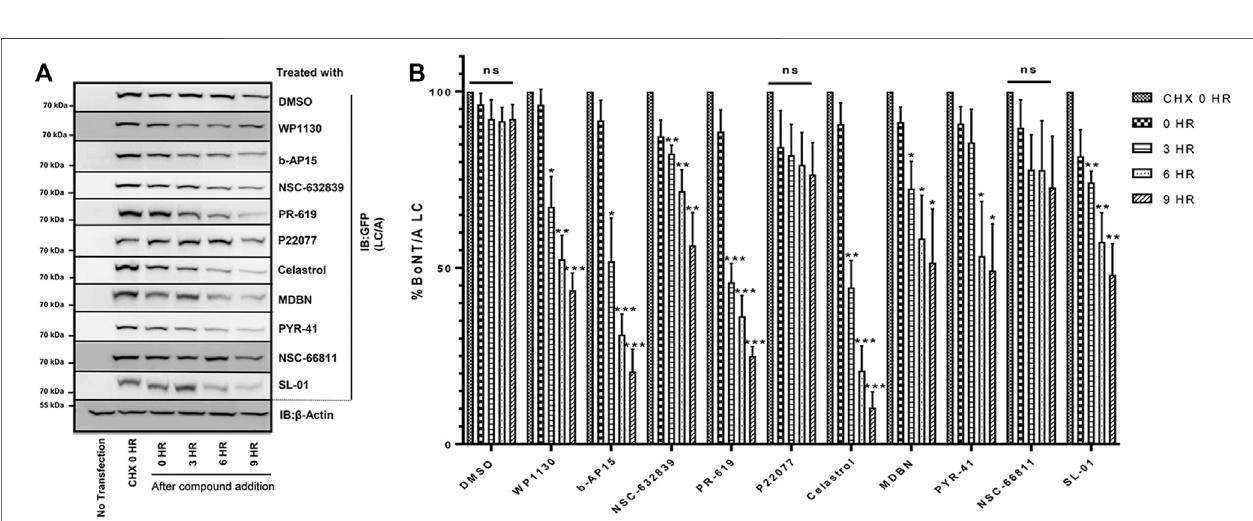
FIGURE5| Selected Compounds Enhancethe Degradation ofBoNT/A LC inCells (A) Representativewesternblot images demonstratingYFP-LCA protein levels attheindicatedtimepoints.HEK293cellsweretransfectedwithYFP-LCAandafter24 hincubatedwithCHX.After2 hofincubationwithCHX,mediawasremoved,and selectedcompounds(20 µM)wereaddedtothecellsandincubatedfortheindicatedtimepoints. “ CHX0 h ” indicatesthetimepointwhenCHXwasadded. “ Compound treatment 0 h ” indicates the time point when compound treatment was conducted. YFP-LCA expression levels were detected using an anti-GFP antibody. Each westernblotwasstrippedandreprobedwith β -Actinastheloadingcontrol,andthe fi gureincludesarepresentative β -Actin. (B) QuantitativeanalysisofYFP-LCAprotein levels for each compound at the indicated time points. The data quanti fi cation was conducted by normalizing the GFP levels to β -Actin of each individual blot. Data are presentedasmeans ± SEMcalculatedfrom threeindependentexperimentsand compared tocorresponding “ CHX0 h ” controlconditionsofeach set,usingGraphPad Prism (Student ’ s t -test). +++ , ++ , + Value signi fi cant at 99.9, 99, and 95% con fi dence level, respectively. “ ns ” stands for not signi fi cant.